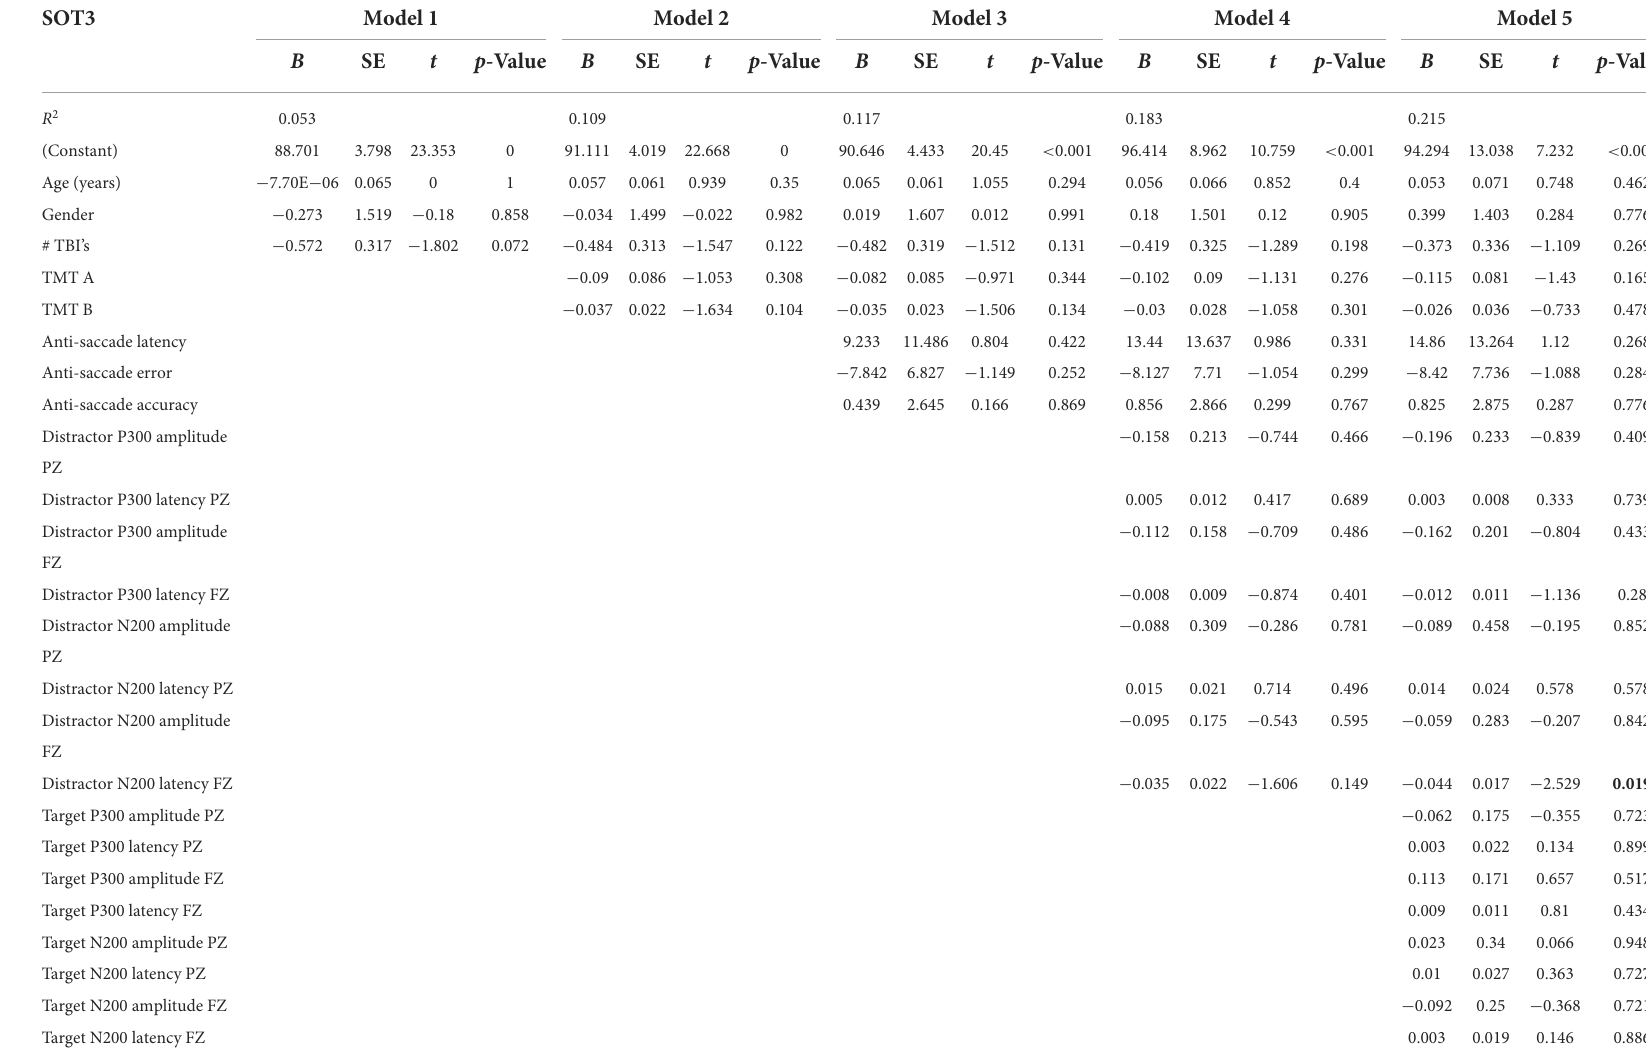
TABLE 5 Results from the hierarchical regression for SOT3, sway-referenced